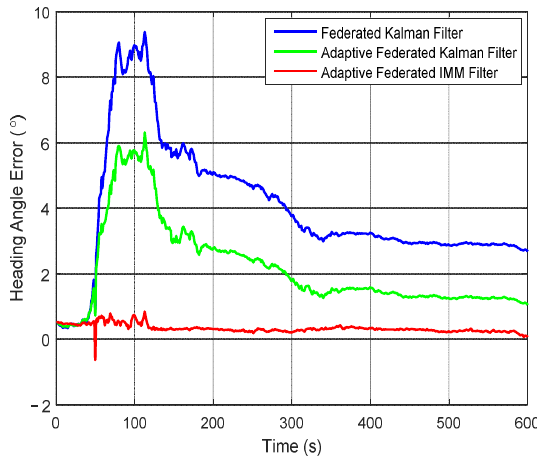
Figure 8. The estimation curves of heading angle error.